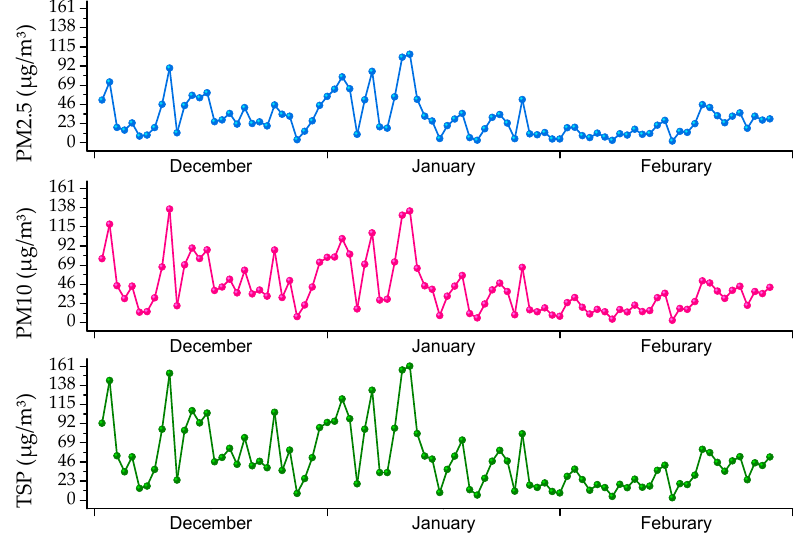
Figure 2. Variation of PMs.